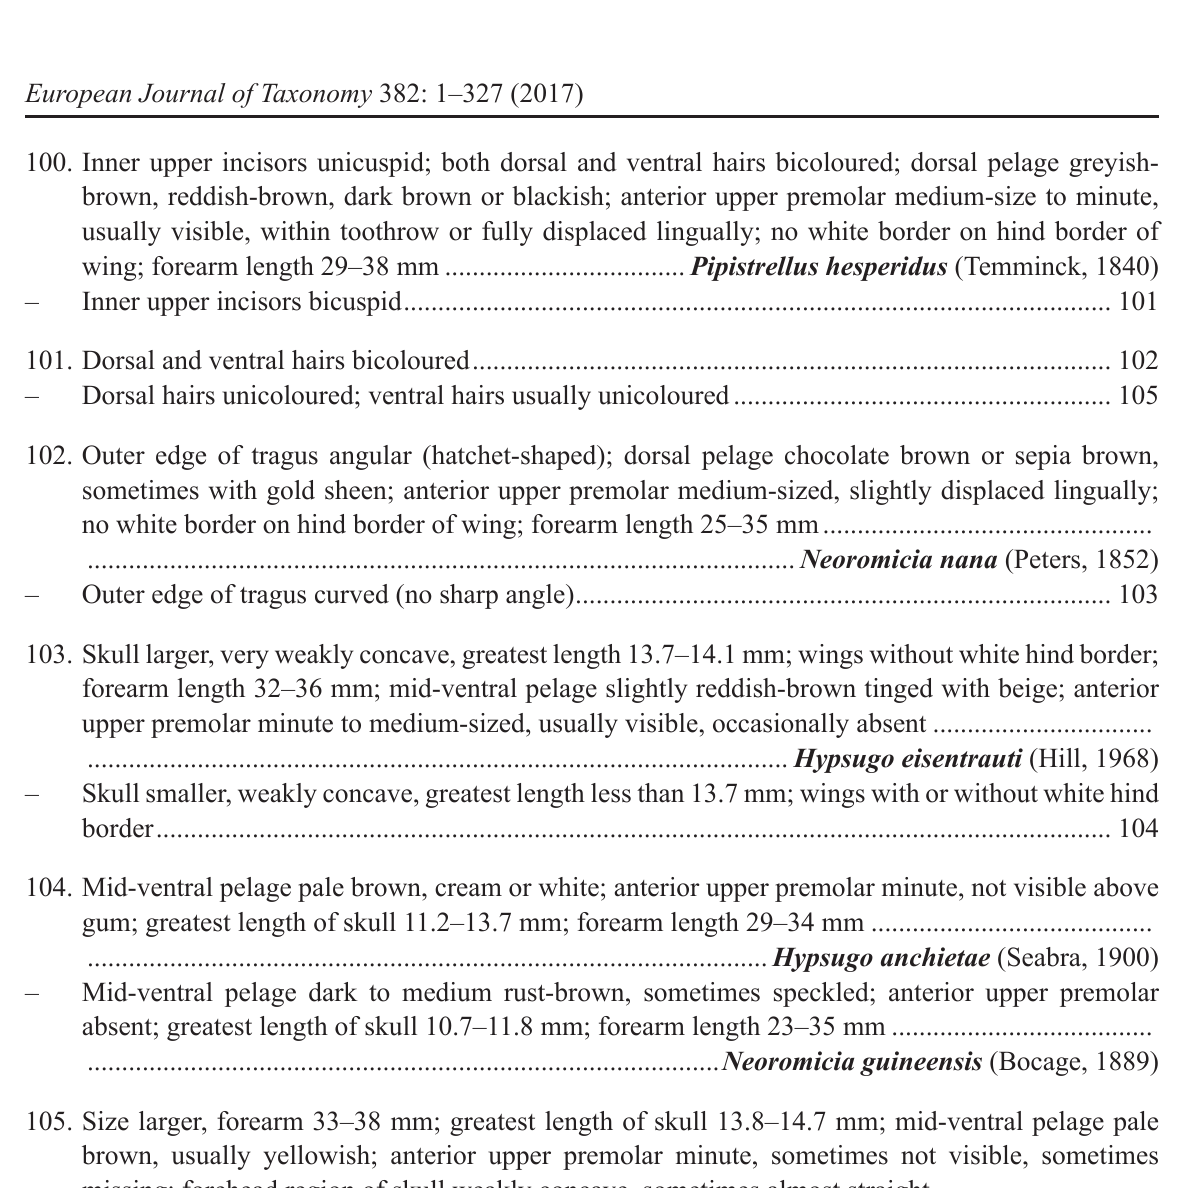
100. Inner upper incisors unicuspid; both dorsal and ventral hairs bicoloured; dorsal pelage greyish- brown, reddish-brown, dark brown or blackish; anterior upper premolar medium-size to minute, usually visible, within toothrow or fully displaced lingually; no white border on hind border